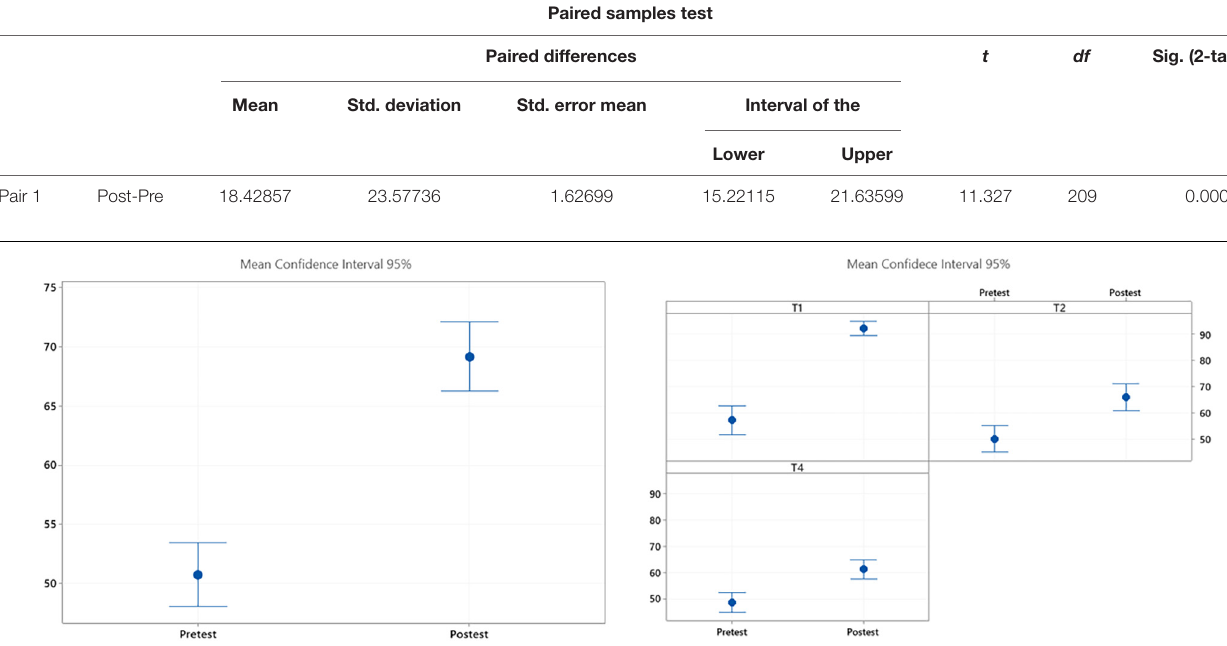
FIGURE 8 | Mean confidence intervals for the pre- and post-tests. The entire sample and per teacher for the second activity.